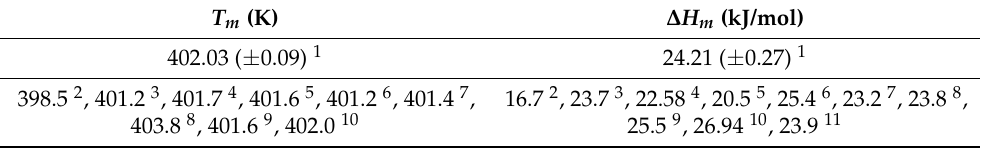
Table 1. Collection of melting temperatures and enthalpy of fusion values of nicotinamide determined in this work and reported in the literature. In the parentheses, the standard deviation values are provided ( n =